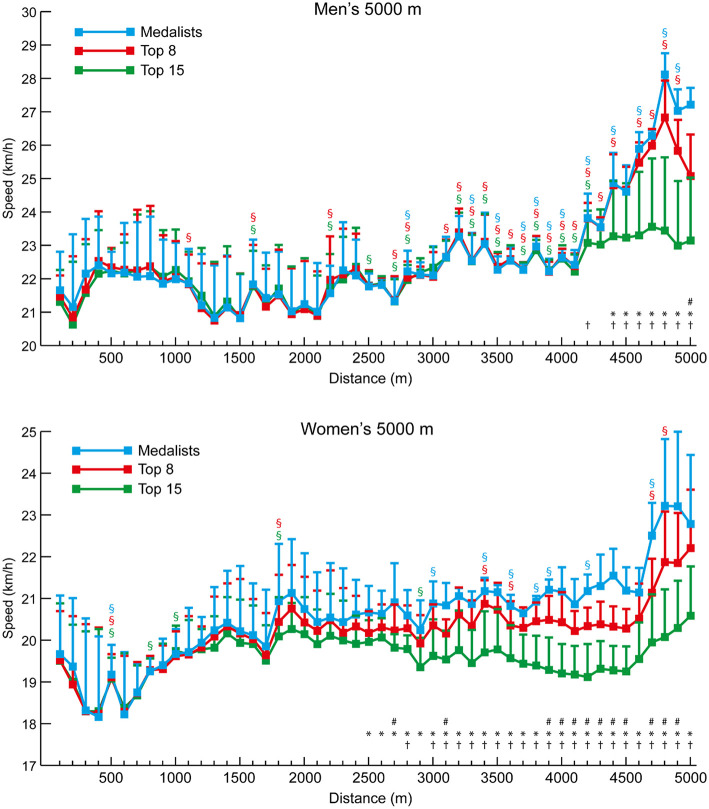
The mean (+ SD) 100-m segment speed for each group of men and women 5,000 m athletes. Differences between successive segments (p < 0.05, d ≥ 0.61) are represented by § (blue for medalists, red for Top 8, and green for Top 15). Differences in segment speed between groups (p < 0.05, d ≥ 0.61) have been annotated for medalists vs. Top 8 (#), medalists vs. Top 15 (*), and Top 8 vs. Top 15 (†).